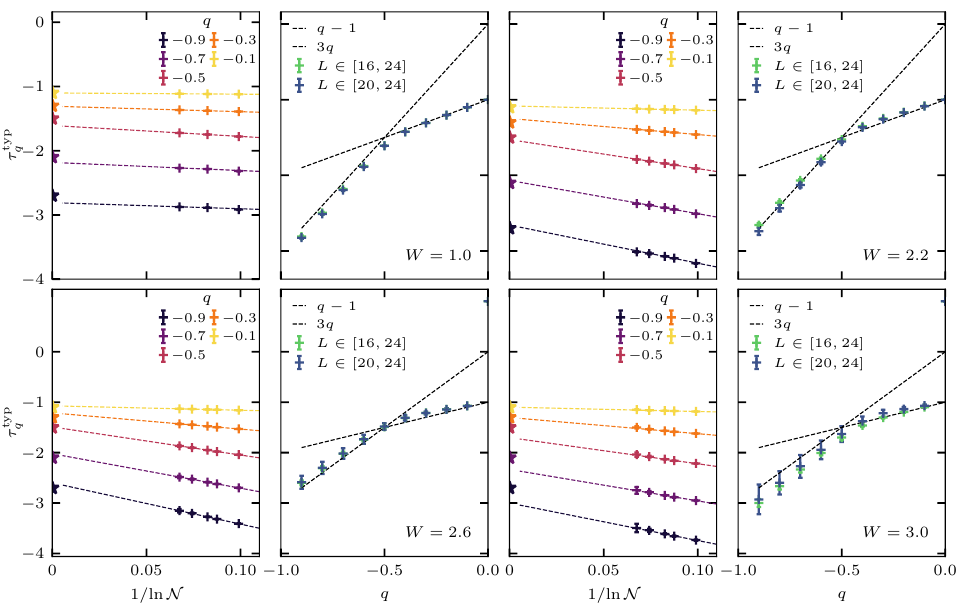
Figure 4: Similar to Fig. 3 but for W = 1.0,2.2,2.6 and 3.0 for q < 0. The dashed for the GOE case, 3 q for black lines correspond to the expected behavior of τ typ q q < − 0.5 and ( q − 1 ) otherwise. See the Eq. (9) for details. Another advantage of τ typ is that unlike τ avg q